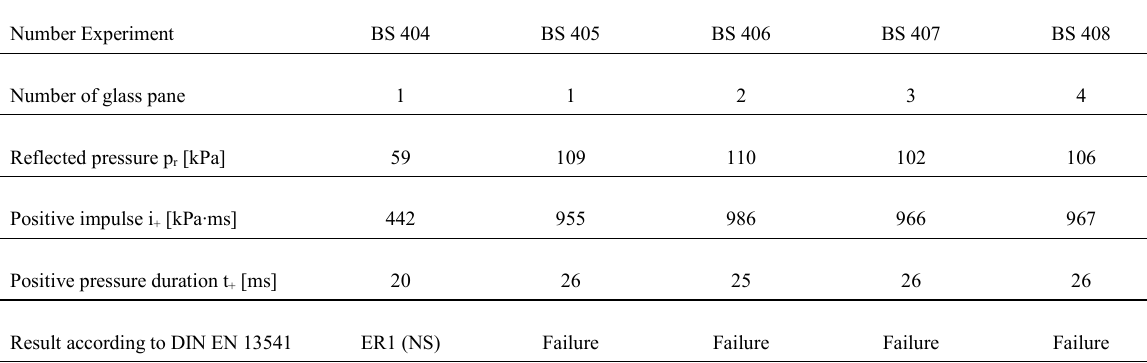
Table 2: Parameters of the pressure